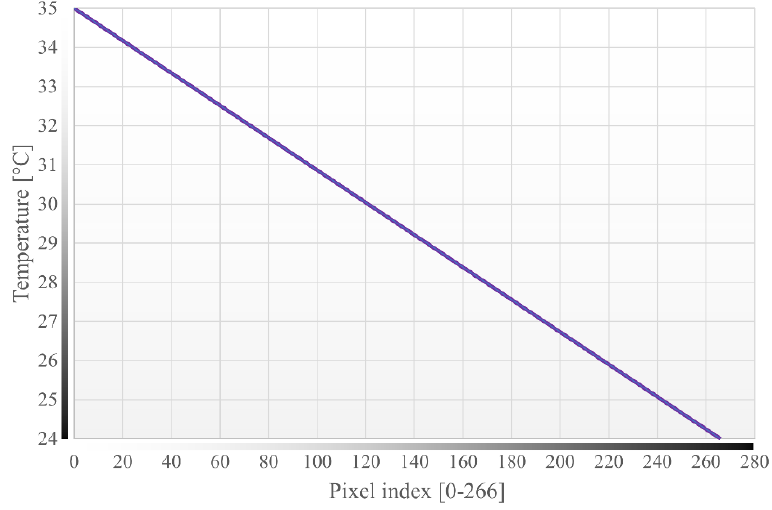
Figure 11. Temperature as a function of pixel position.